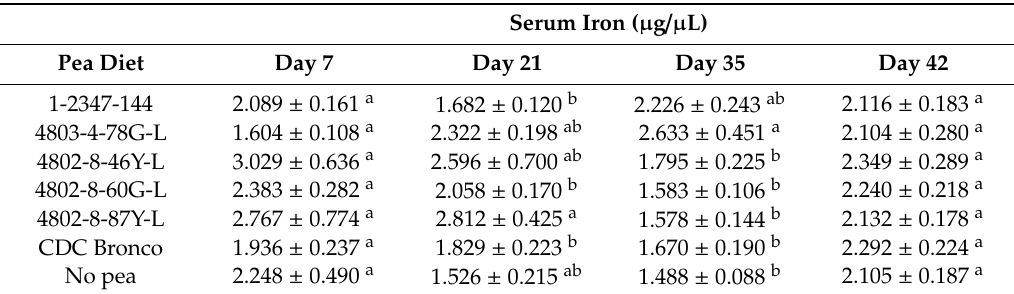
Table 10. Serum iron concentrations 1